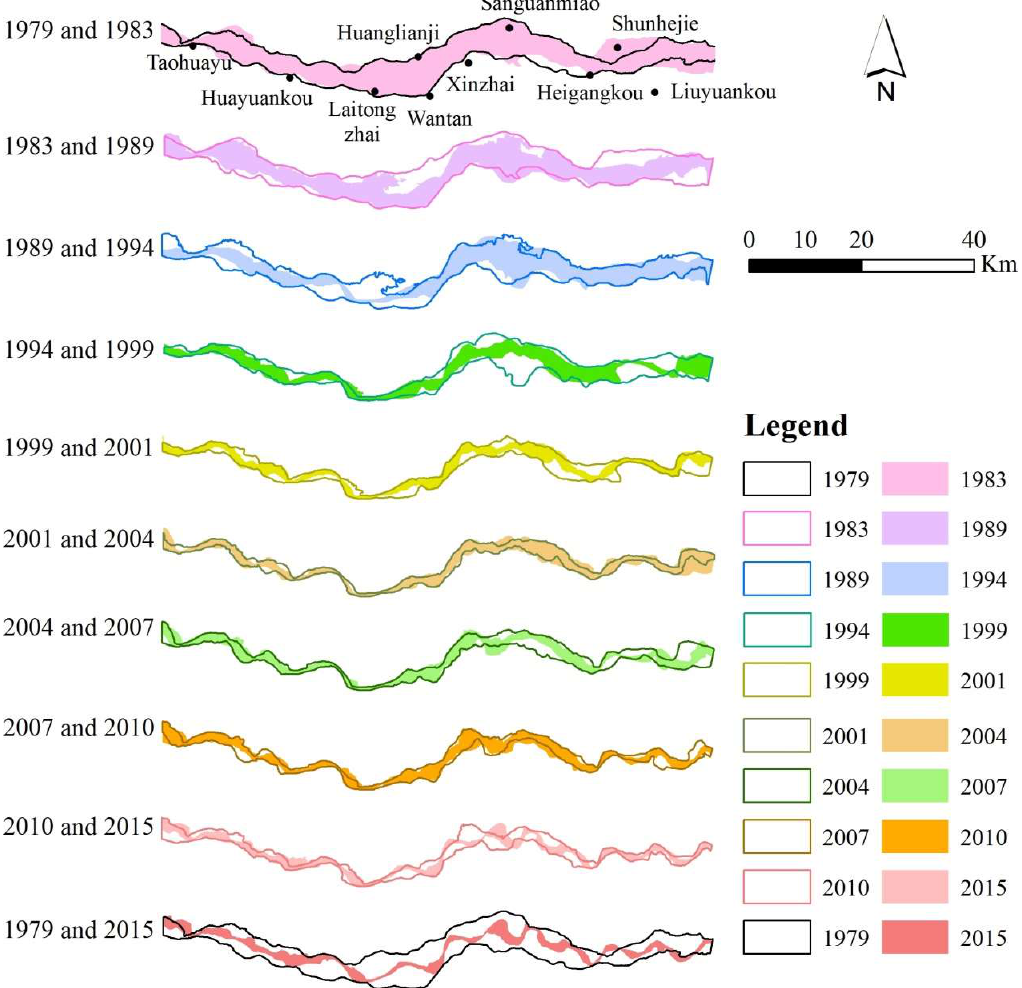
Figure 8. Maps of the wandering belt configurations in different periods in the study reach extracted from the selected Landsat images. Note: In each map, the outline is drawn in terms of the Landsat image taken in the earlier date while the color area is extracted from the Landsat image taken during the later date.